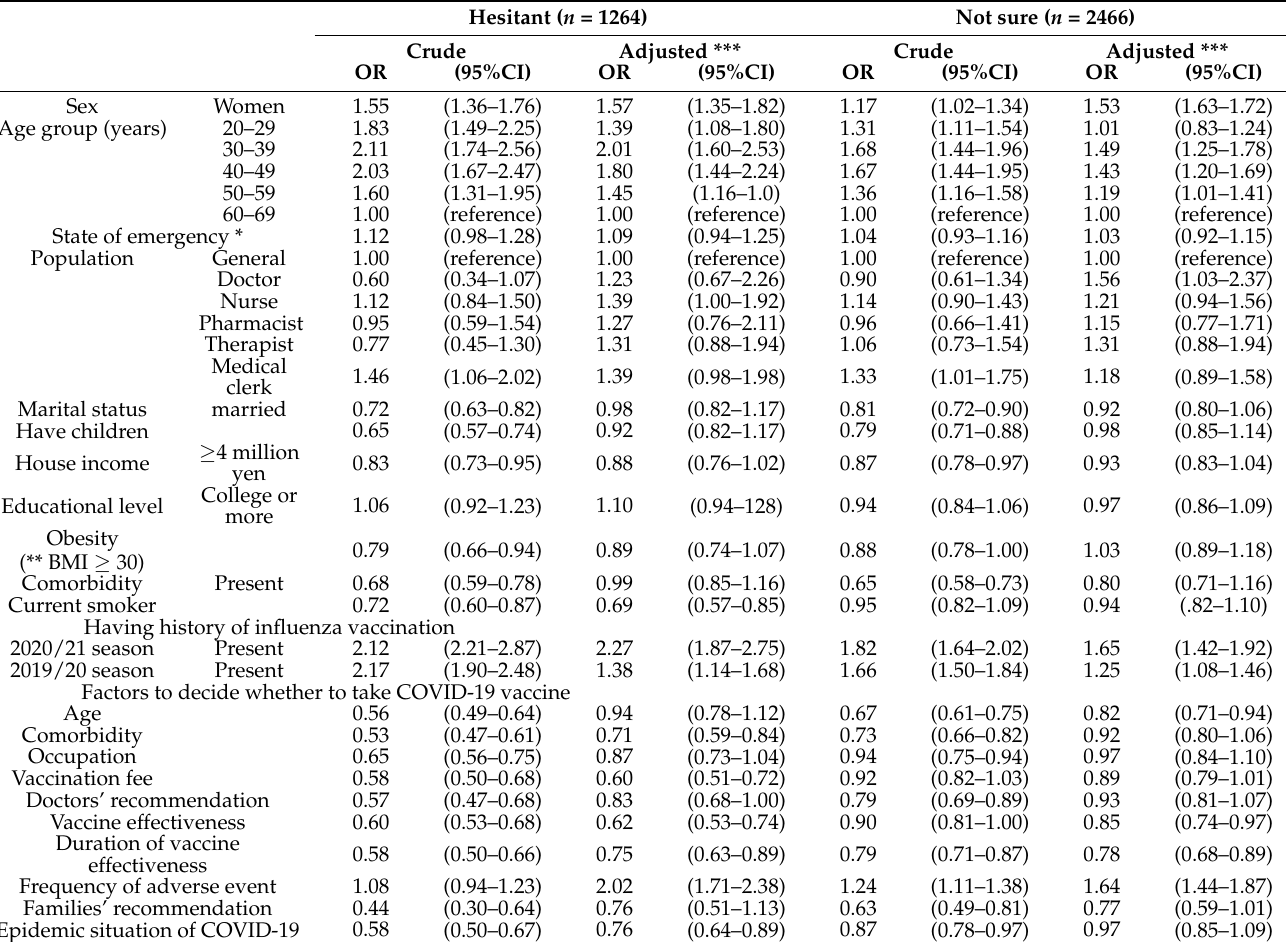
Table 3. Factors associated with vaccine